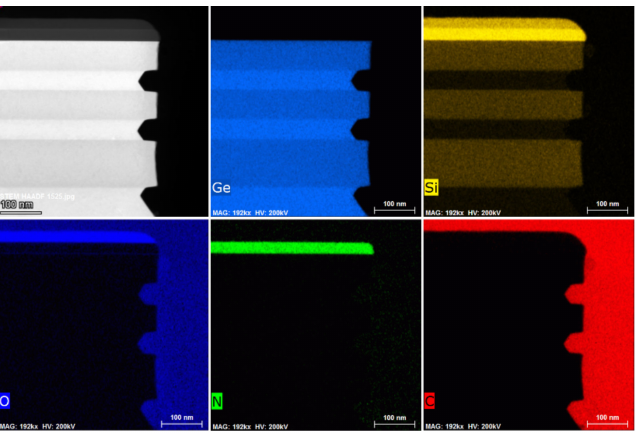
Figure 8. EDS mapping near etching regions with elements Ge, Si, O, N, and C, the sample etching for 15 cycles (oxidation time t ox = 30 s; temperature of HNO 3 = 20 ◦